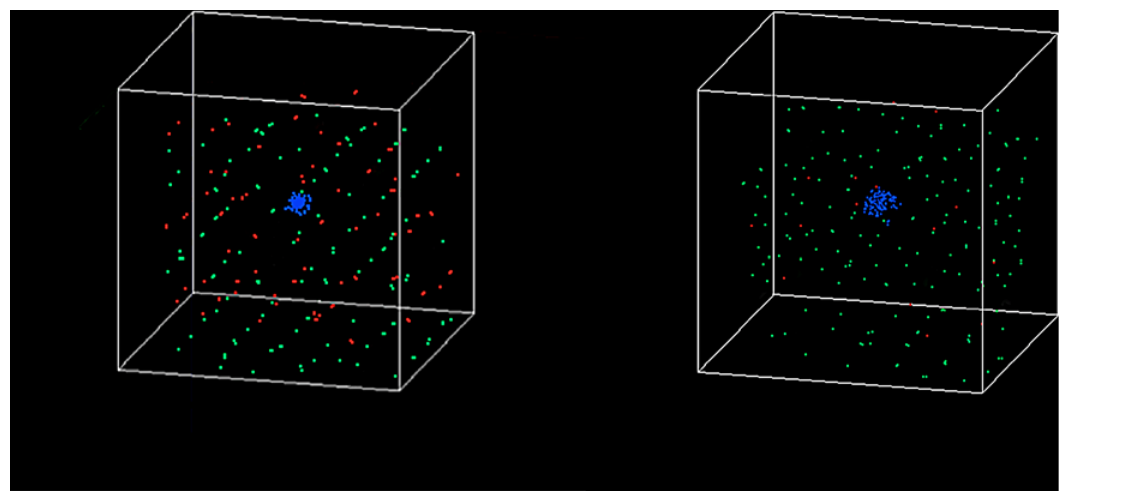
Fig 5. 3D snapshots of the tumor system without drug treatment at (a) time step 90 and (b) time step 120.